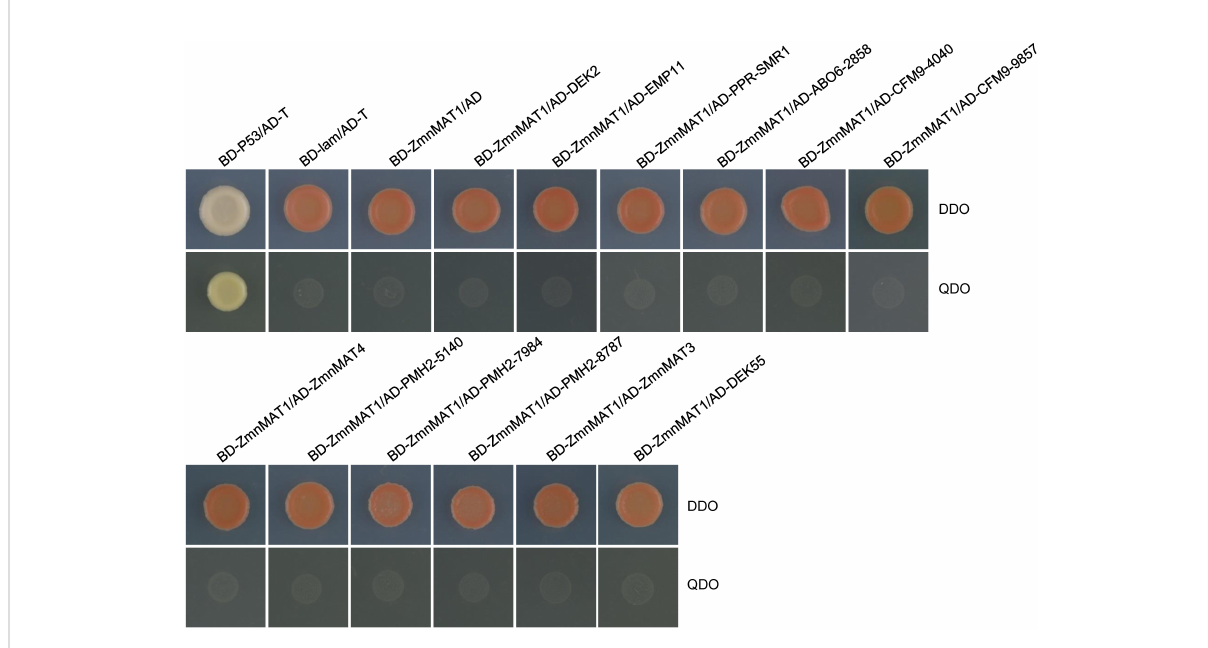
FIGURE 9 Y2H analysis of the interaction between ZmnMAT1 with factors involved in the splicing of Nad1 intron 1 and/or Nad4 intron 2. The Y2H strains harboring the indicated bait and prey constructs were spotted on SD-Trp-Leu (DDO) and SD-Trp-Leu-His-Ade (QDO).The interaction between T-antigen and Human P53 was used as a positive control. The interaction between T-antigen/Lam and BD-ZmnMAT1/AD were used as negative controls. AD, activation domain; BD, binding